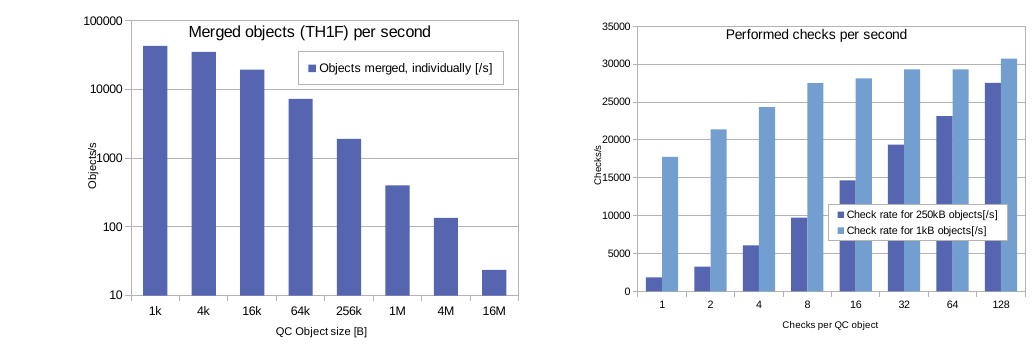
Figure 4. The performance of Merger as a function of the histogram size.